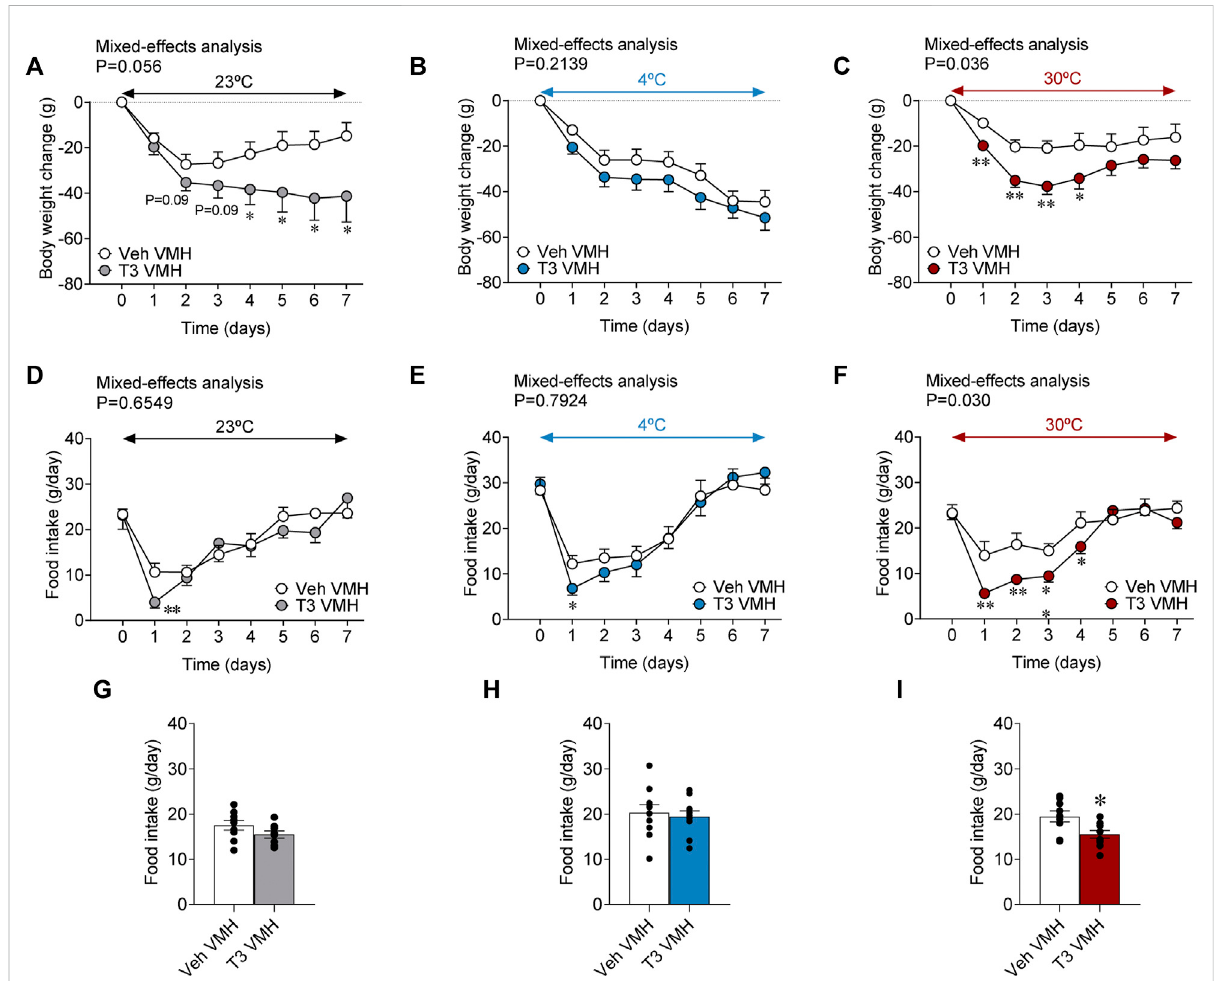
FIGURE 4 Effects of temperature on energy balance in rats centrally treated with T3 (A – C) Body weight change, (D – F) food intake, and (G – I) daily food intake of rats stereotaxically treated with vehicle or T3 housed at 23 ° C (A,D,G) , 4 ° C (B,E,H) or 30 ° C (C,F,I) . Data are represented as MEAN ± SEM. n = 9 – 11 rats/group. Statistical signi fi cance was determined by Mixed effect analysis or Student ’ s t-test. * p < 0.05, ** p < 0.01 vs. vehicle